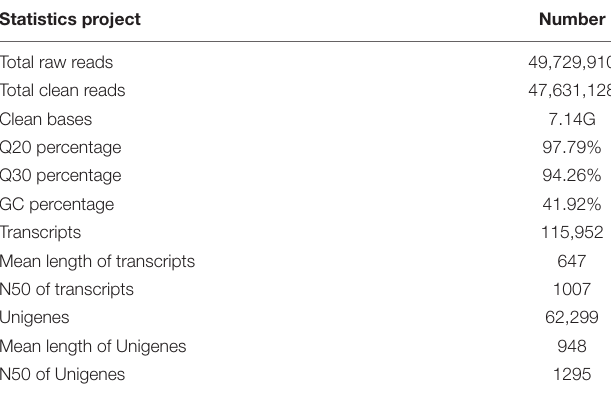
TABLE 1 | Summary of A. germari antennae